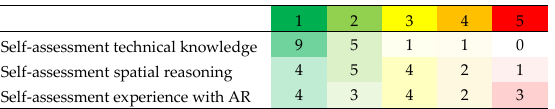
Table 1. Self-assessment of the participants as captured in the questionnaire. The participants had the possibility to answer from very good (1) to very poor (5).